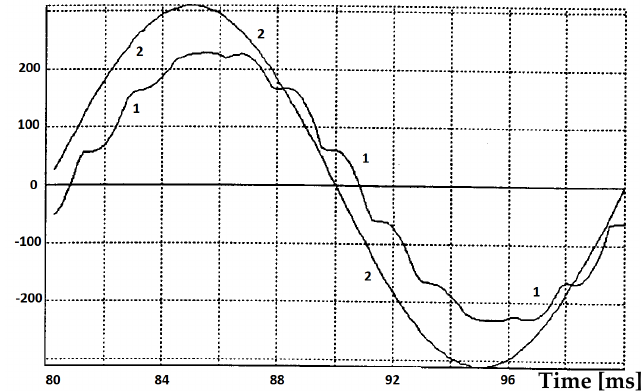
Figure 10. Oscillograms of current i R-1 and voltage u R-2 in the supply line: 1 – current, 2 - voltage at rated converter load.